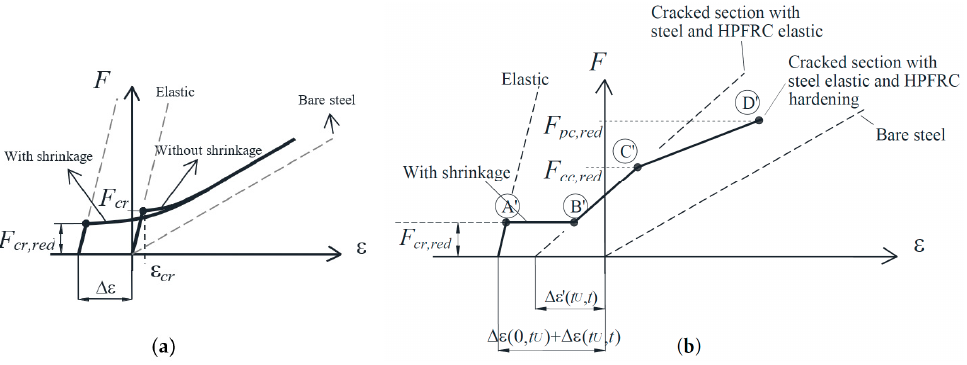
Figure 12. Effect of shrinkage on the behavior of tension members: ( a ) RC; ( b ) RC-HPFRC.